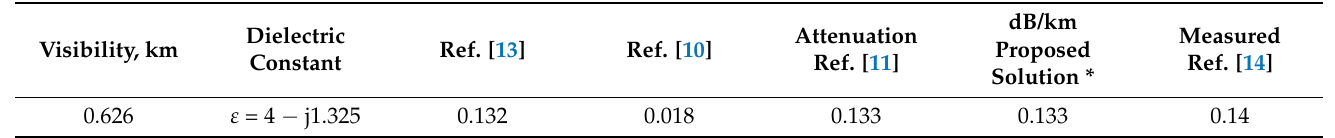
Table 4. Result of measurements and calculations of attenuation [dB/km] due to dust storm; Fre- quency 40 GHz (Ka-band); Equivalent dust particle radius r e = 30 µ